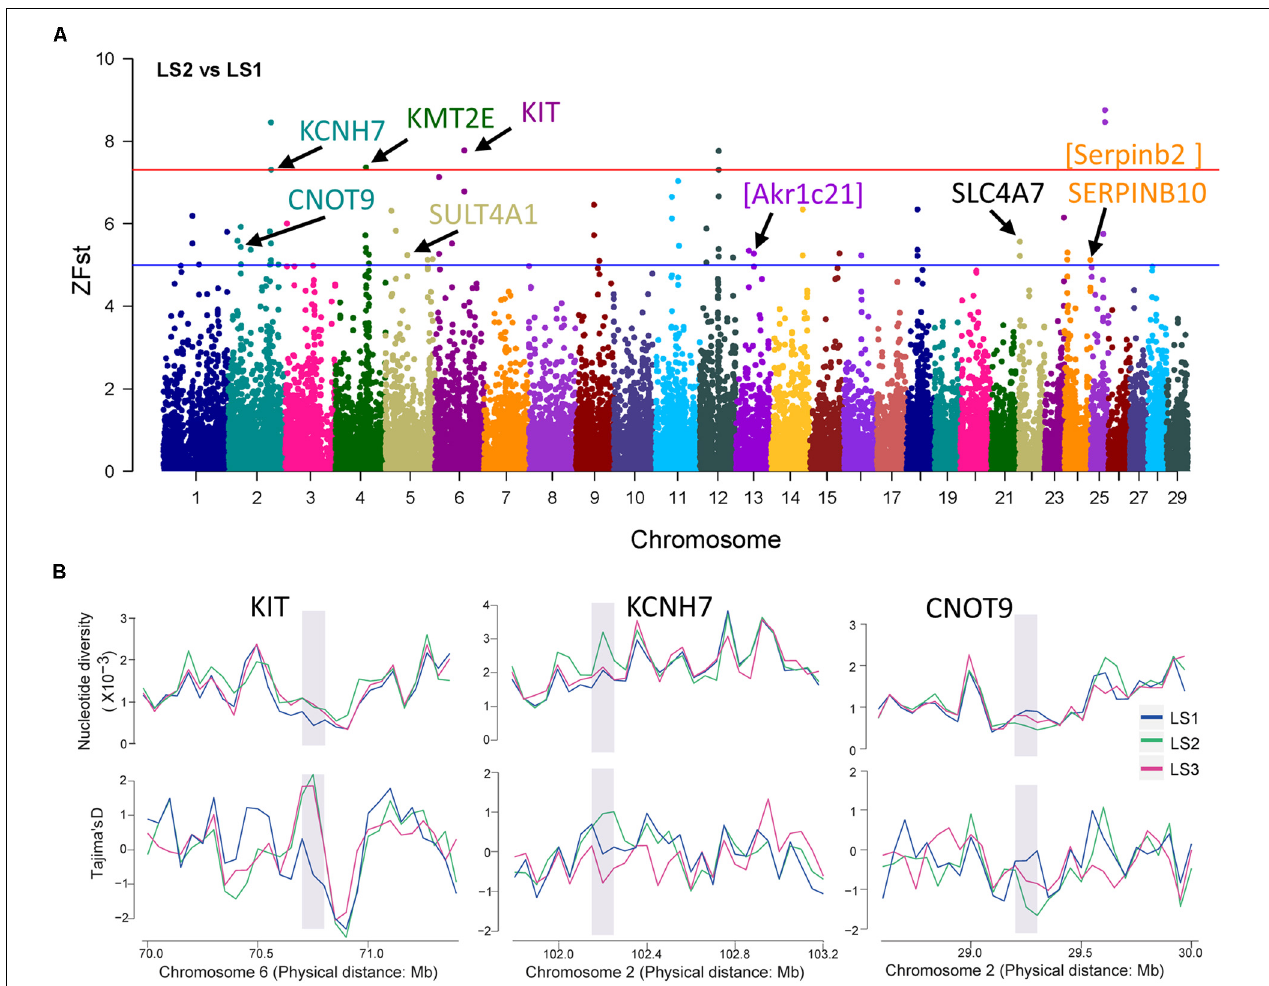
FIGURE 3 | Selective sweep of Jining Gray goat groups with LS2 vs LS1. (A) Mahattan Plot of Z(Fst) values of LS2 vs LS1 group. The blue line is “suggestiveline,” –log10(1e – 05), red line is “genomewideline,” –log10(5e – 08). (B) Distribution of Tajima’s D values and π in LS1, LS2, and LS3 groups at selective regions. The selective regions were marked with gray